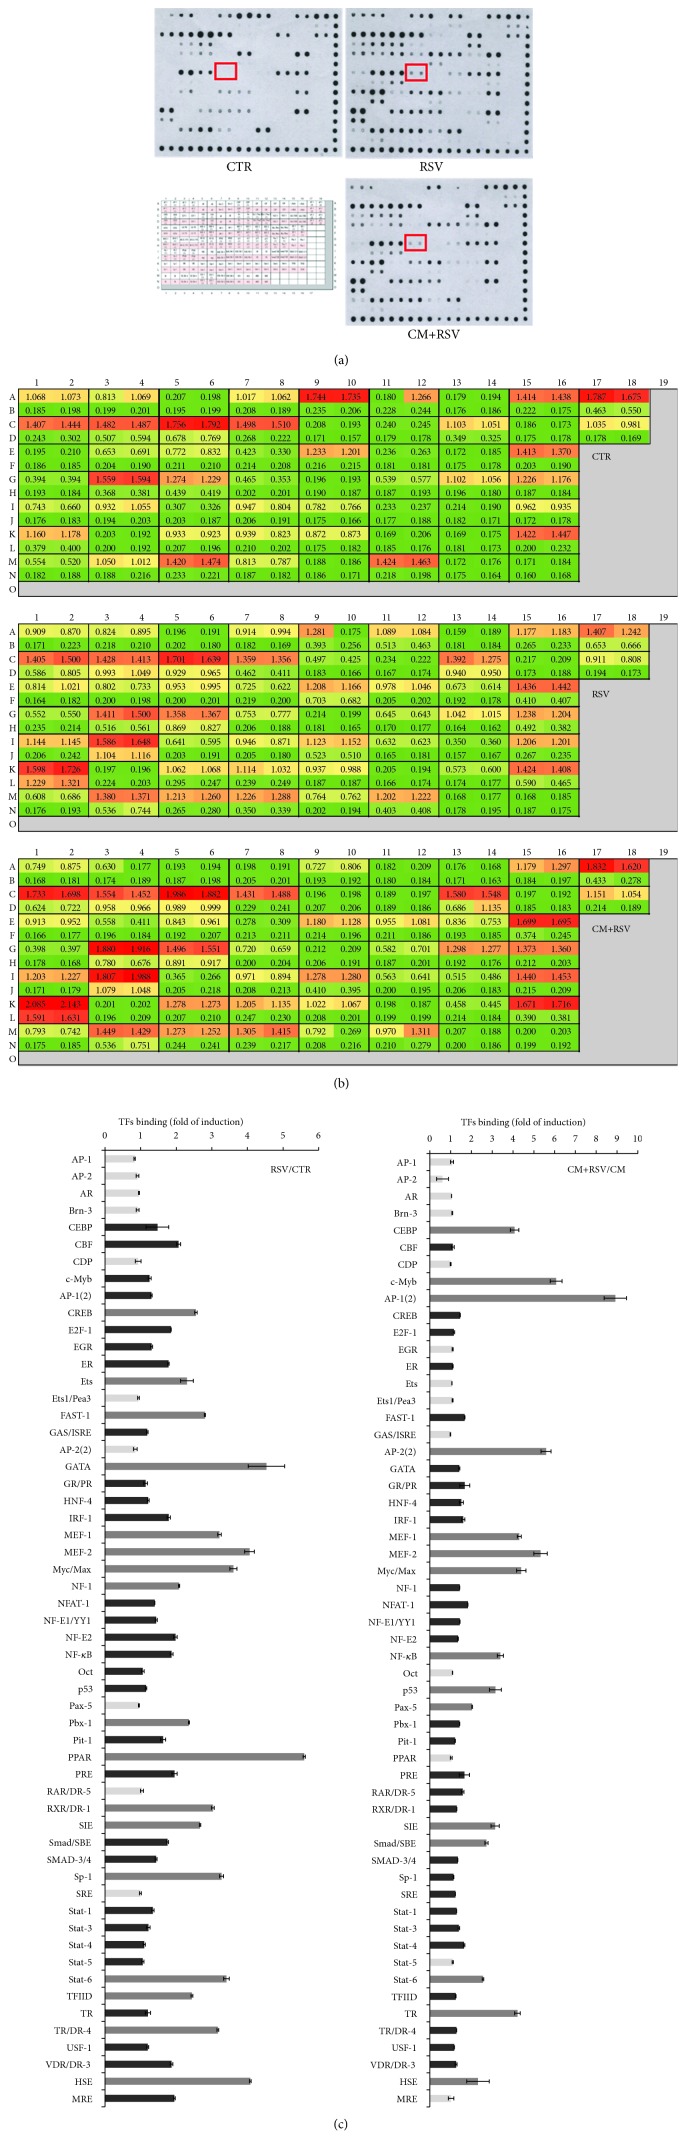
Modulation of neuronal transcription factor activity by glial activation and RSV. (a) Protein-DNA array of nuclear extracts prepared from cortical neurons treated for 2 h with CM (from LPS-stimulated astrocytes), RSV (10 μM), or CM-LPS plus RSV. The grid for location of transcription factors (https://www.biocat.com/bc/pdf/MA1210_MA1215_Protein_DNA_Arrays). (b) Quantitation of transcription factors. (c) Bar graph for quantitative analysis of the ratio RSV/CTR and CM-LPS+RSV/CM-LPS. Light grey square = no change or reduction versus CTR; dark grey square = induction versus CTR (1 > 2‐fold); grey square = induction versus CTR (>2‐fold).